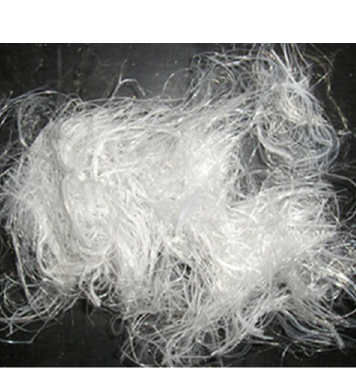
Figure 1. Polyester fiber.